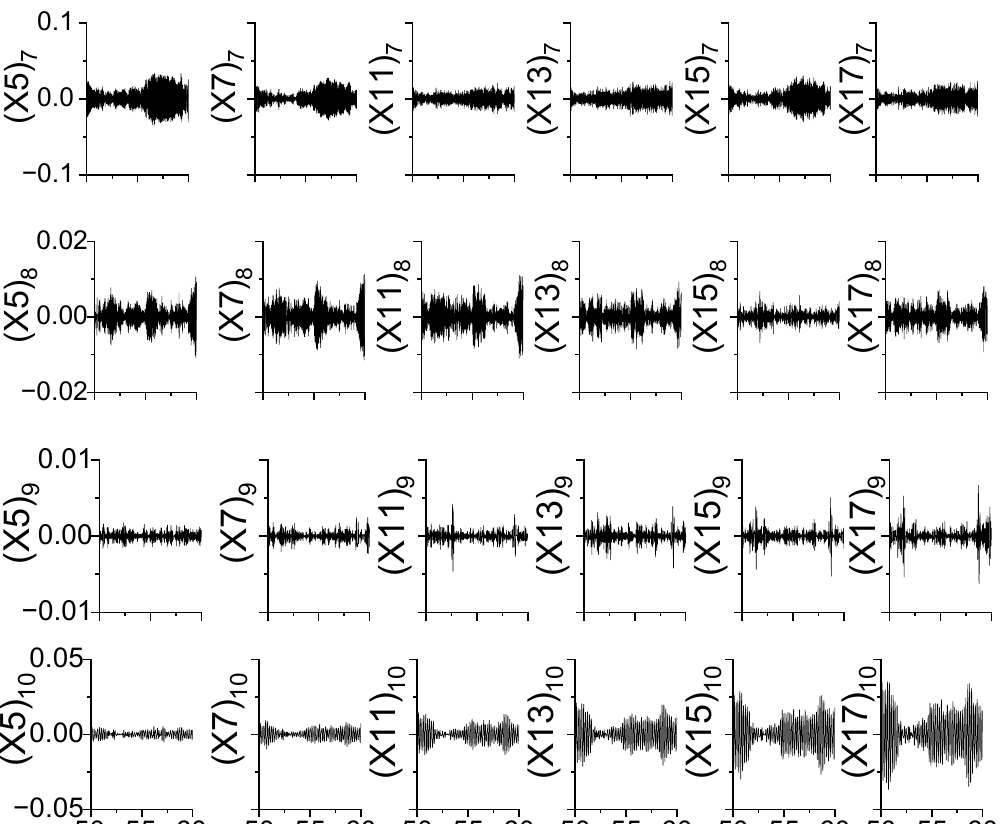
Figure 12. 7th–10th IMFs of X-direction response of Canton Tower.